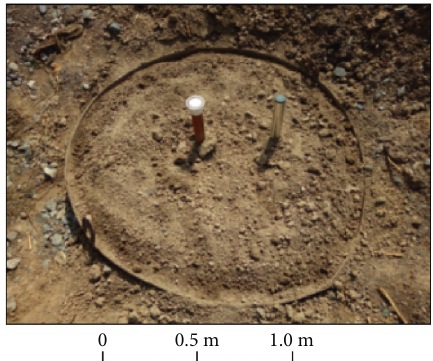
Figure 6: Uncompacted reclaimed soil test barrel.